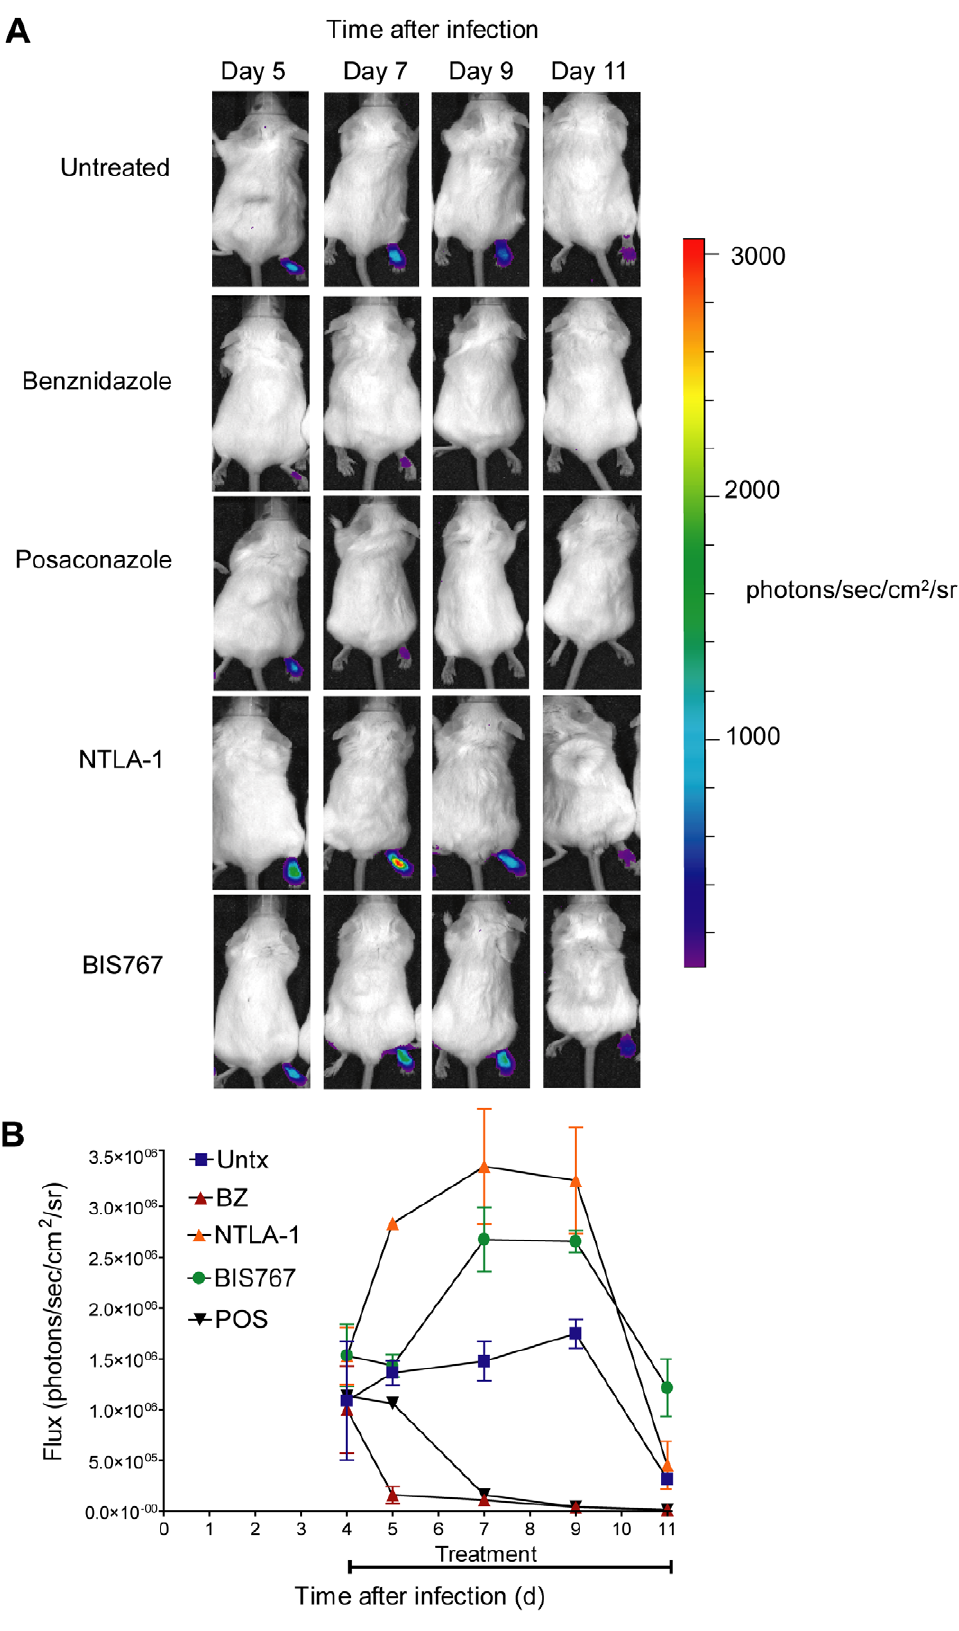
Figure 6. Luminescent T.cruzi imaged at various times post-treatment. (A) Mice (10 per group) were infected in the footpad with 1 6 10 5 T. cruzi bioluminescent trypomastigotes. For all images shown the color scale ranges from blue (with a minimum set at 60 photons/s/cm 2 /sr) to red (maximum of 3000 photons/s/cm2/sr). (B) Quantification of luminescent signal from mice in panel A.